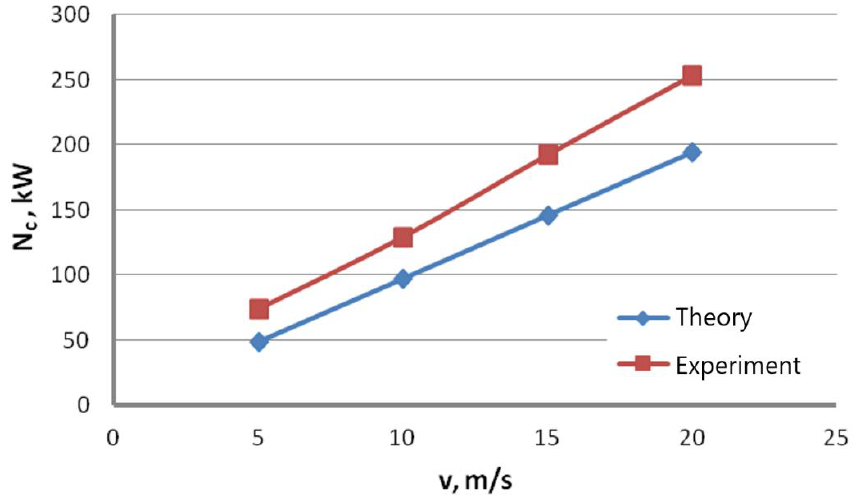
Figure 11. Change of the total theoretical and actual drawing power for hydrodynamic dies as a function of drawing speed.